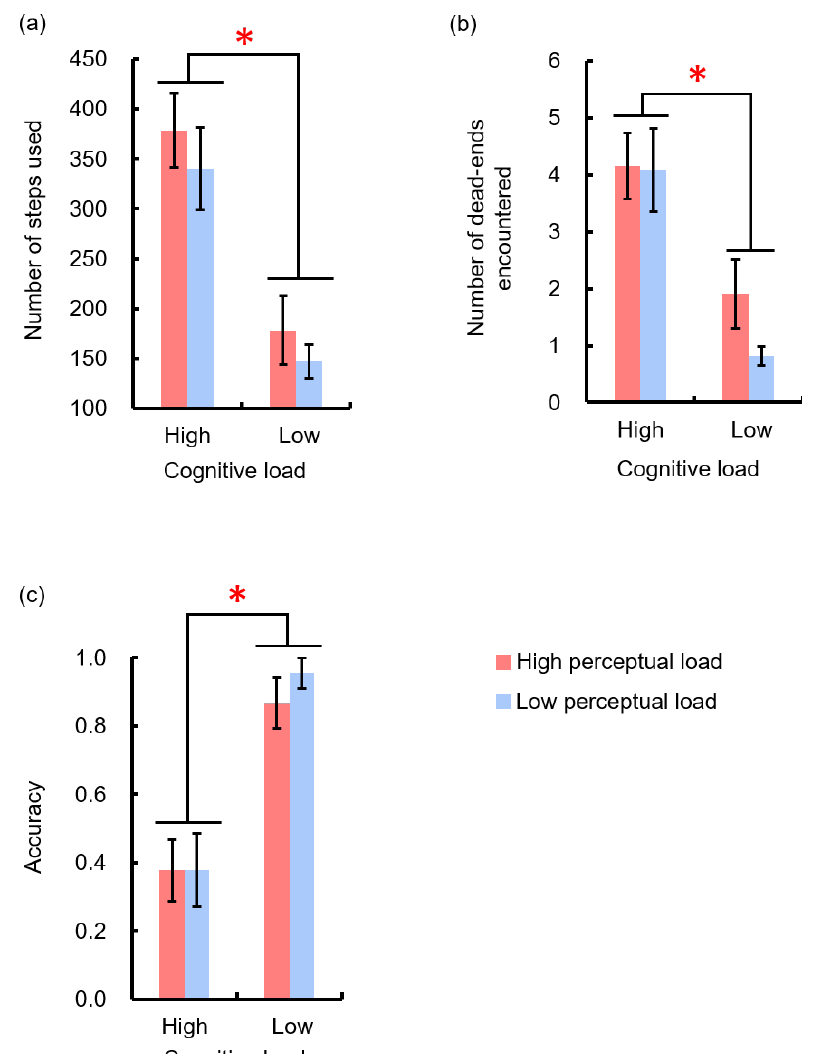
Figure 7. Behavior performance in episodes with the different mental workloads. When encountering episodes with a higher cognitive load, participants ( a ) needed more steps to pass the episode, ( b ) encountered a higher number of dead-ends, and ( c ) had a lower accuracy. Error bars refer to one standard error from the mean. * p < 0.05.